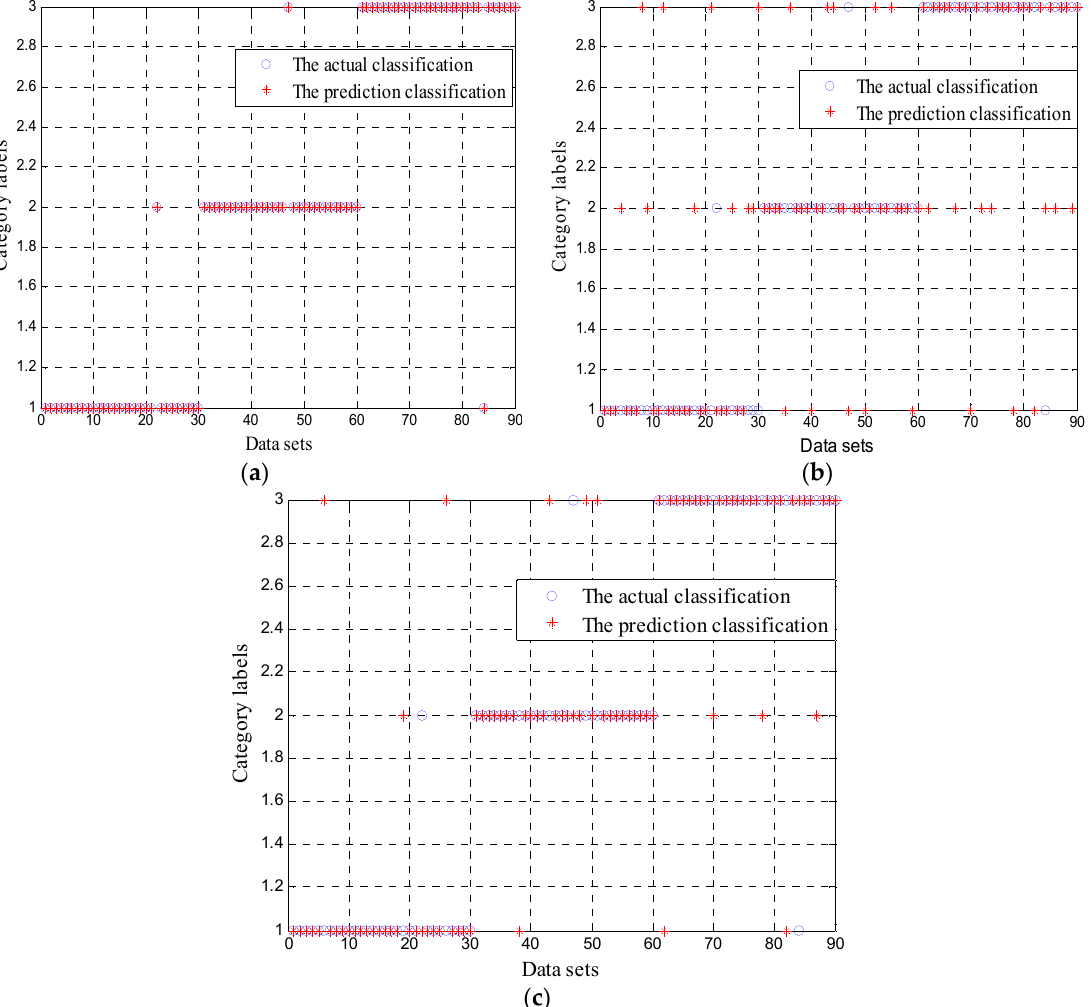
Figure 12. Classification of test figure: ( a ) obtained by ACC; ( b ) obtained by BP; and ( c ) obtained by SVM.